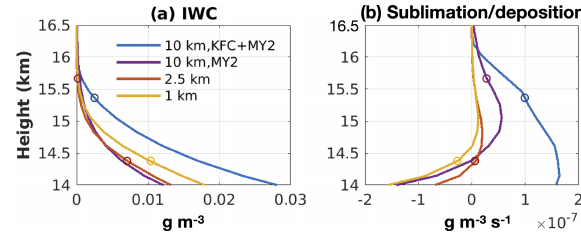
Figure 10. Mean profiles between 14km and 16.5km within Do- main A and the evaluation time window (5h): (a) ice water content, (b) ice sublimation and vapour deposition tendency. The circles in- dicate the position of tropopause (mean (cid:48) < 2 ◦ Ckm − 1